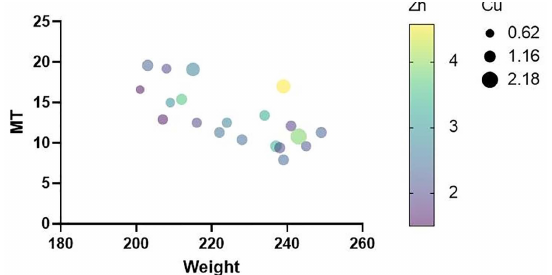
Fig. 3. Linear regression between MT and Weight of the animals, considering zinc and copper concentrations in blood